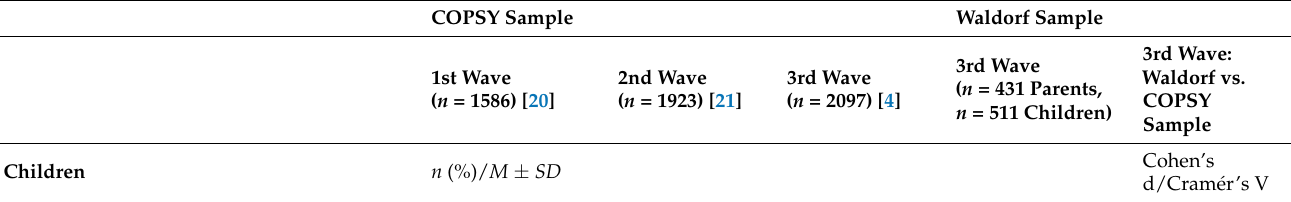
Table 1. Demographics of the Waldorf and COPSY